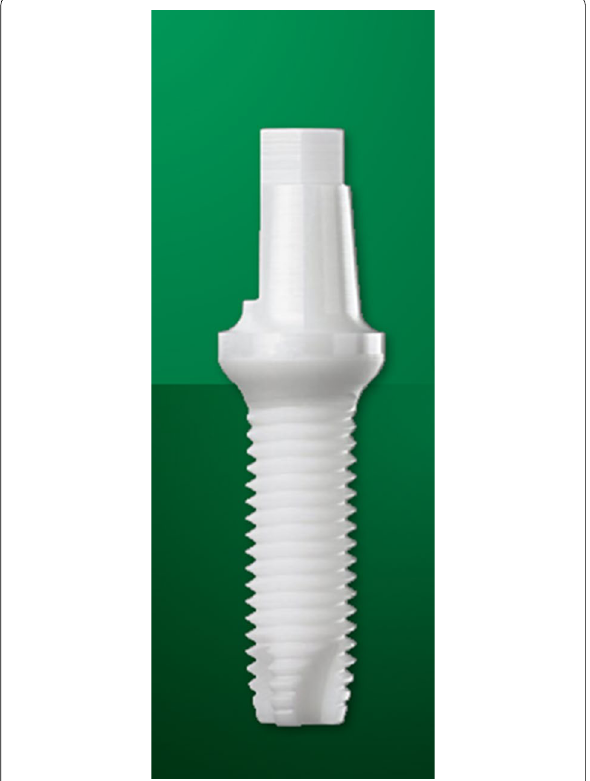
Fig. 1 Zirconia one‑piece dental implants